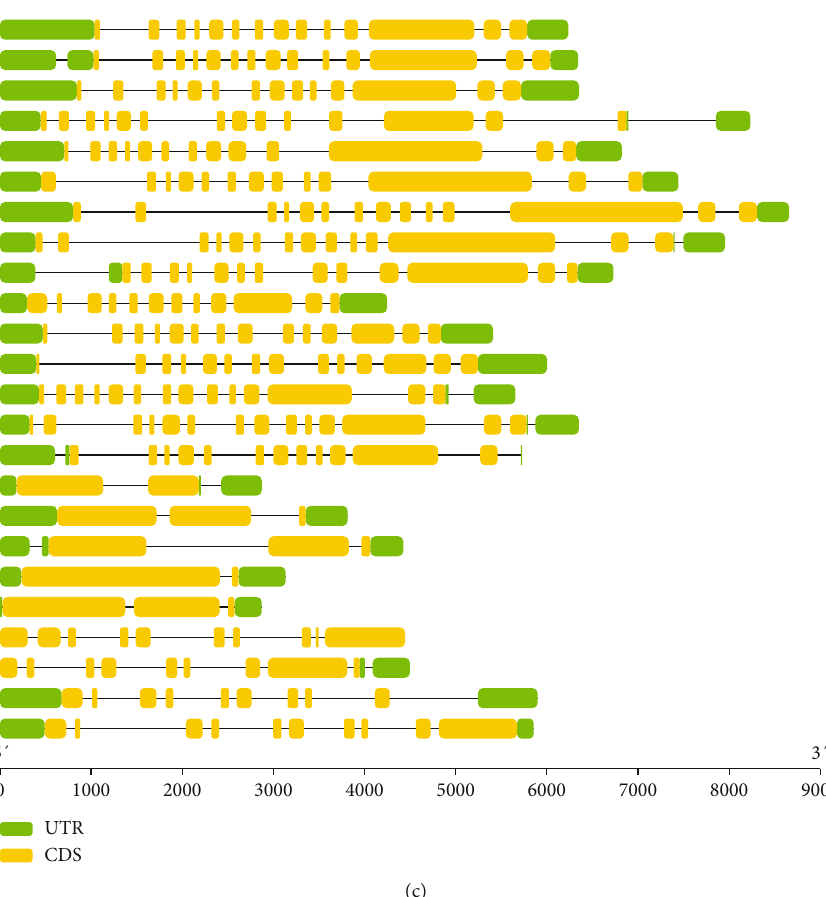
Figure 5: (a) Phylogeny reconstruction and (b) amino acid composition of (c) middle regions and gene structure of SiARFs.